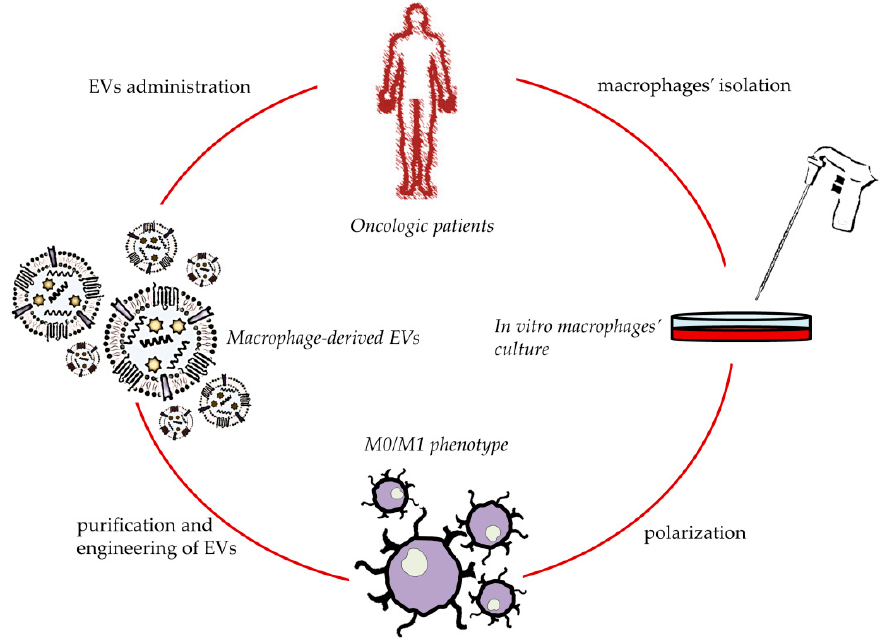
Figure 3. Schematic development of personalized anticancer therapies based on macrophage-derived EVs.